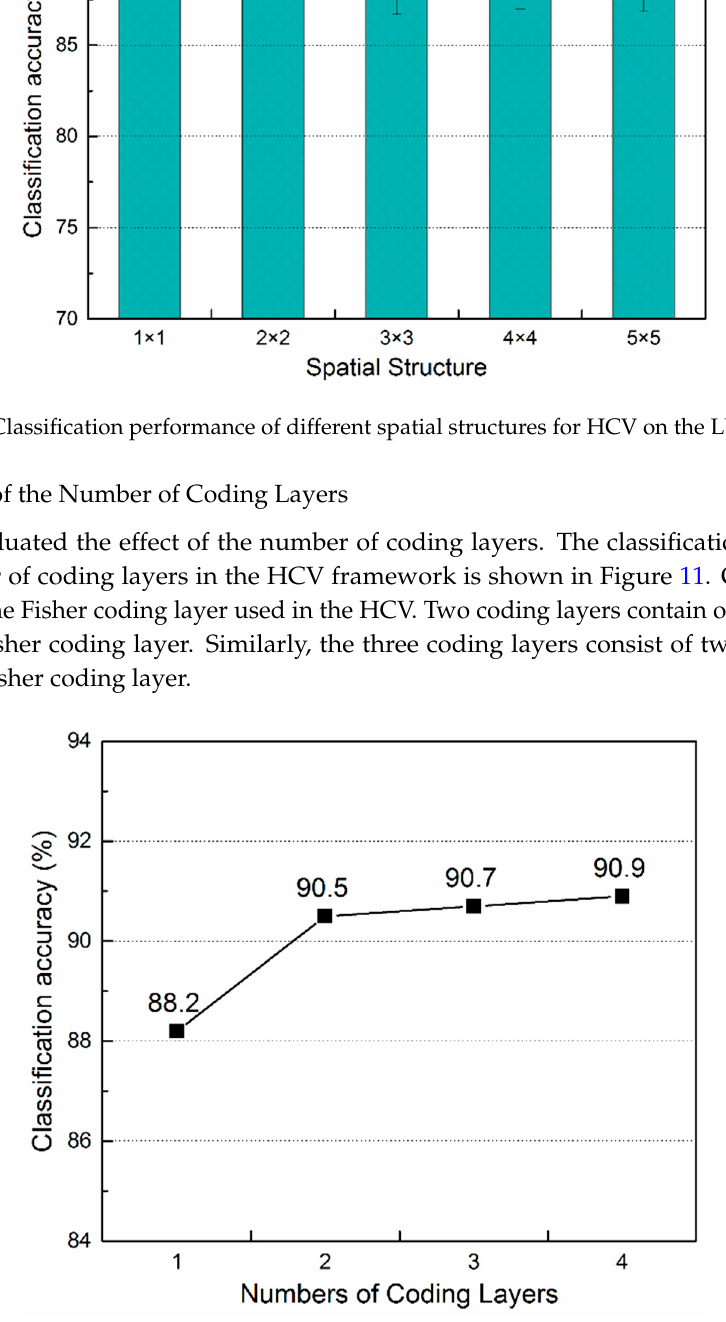
Figure 11. Evaluation of the effect on the classification accuracy of the number of coding layers.